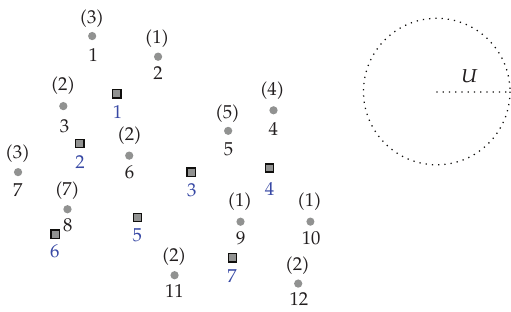
Figure 1: A MCLP